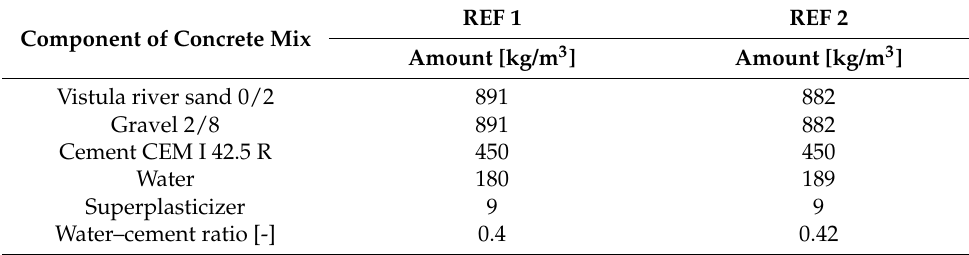
Table 1. Composition of the reference series.